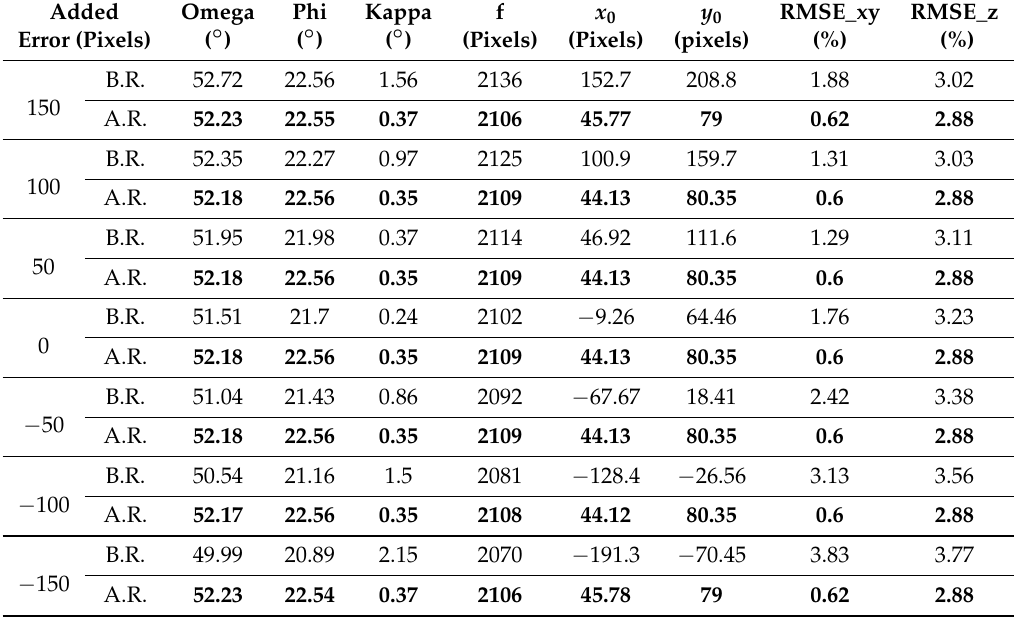
Table 1. The performance of the proposed vanishing point refinement algorithm. System error on V x was manually added to validate the reliability under different initial vanishing point